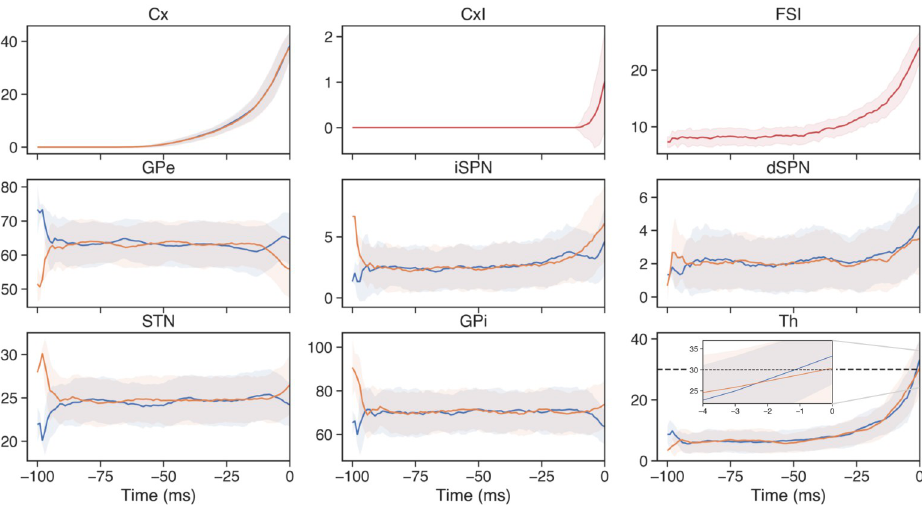
Fig 2. Mean firing rates of the populations in the CBGT network on choice A trials. The firing rate in spikes/s is averaged across all trials for which action A was selected with the control set of synaptic conductances (third column in Table 3), from the stimulus onset time at Cx to the decision time (set to be 0). Blue traces correspond to the sub- populations affecting the A action, orange traces represent the sub-populations impacting the B action, and red traces are used for the populations ( CxI and FSI ) common to both action channels. Shadow areas represent the standard deviation for each population. Since each trial had a different reaction time, we performed the averaging by aligning trials on their decision times. Same cell type abbreviations as in Fig